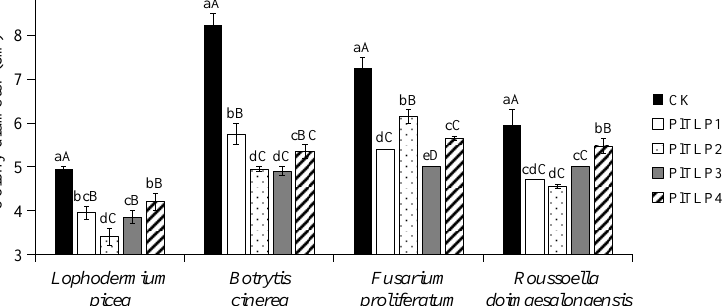
Figure 7. Antifungal activity of recombinant PlTLP proteins against four plant fungal species. CK: fungi were grown on plates without the recombinant PlTLP proteins. PlTLP1–4 : fungi were grown on plates containing 1 nmol of recombinant PlTLP1, PlTLP2, PlTLP3, and PlTLP4 proteins, respec- tively. L. piceae were cultured at 25 °C for 15 d; B. cinerea , F. proliferatum , and R. doimaesalongensis were cultured at 25 °C for 5 d. Data represent the mean values ± SE ( n = 3 independent replicates). Different lowercase letters and uppercase letters indicate statistically significant differences at p < 0.05 and p < 0.01, respectively.